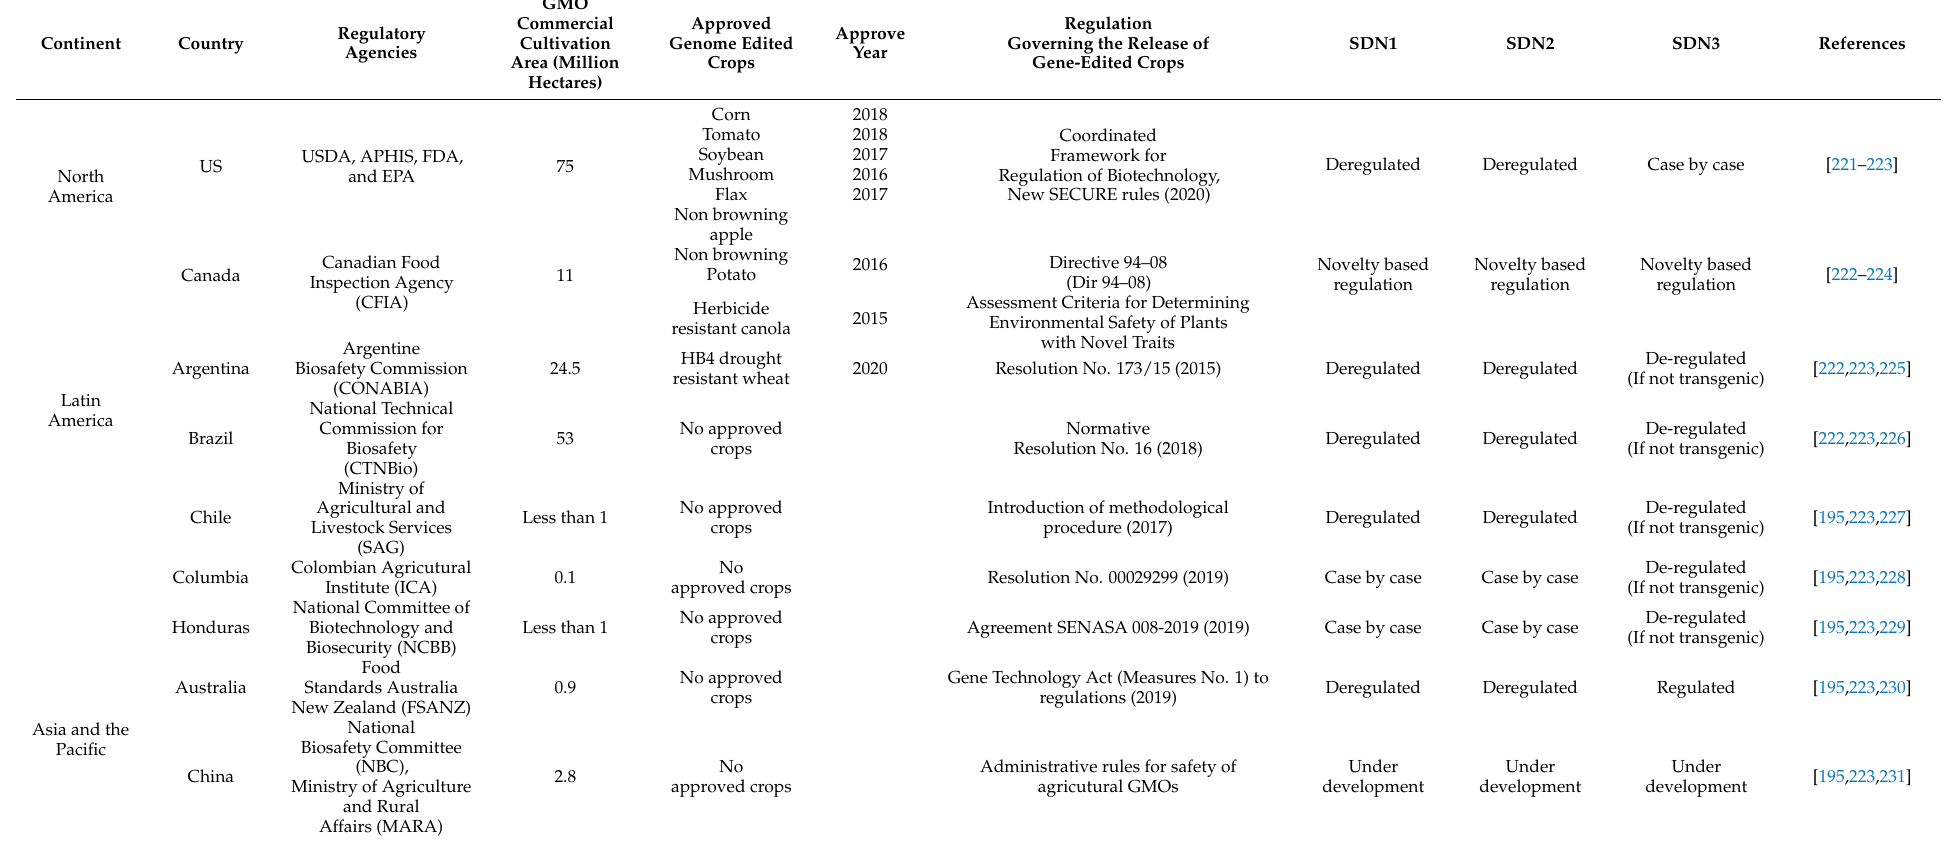
Table 1. Details of worldwide commercially approved genome-edited crops and legislation on the release of gene-edited